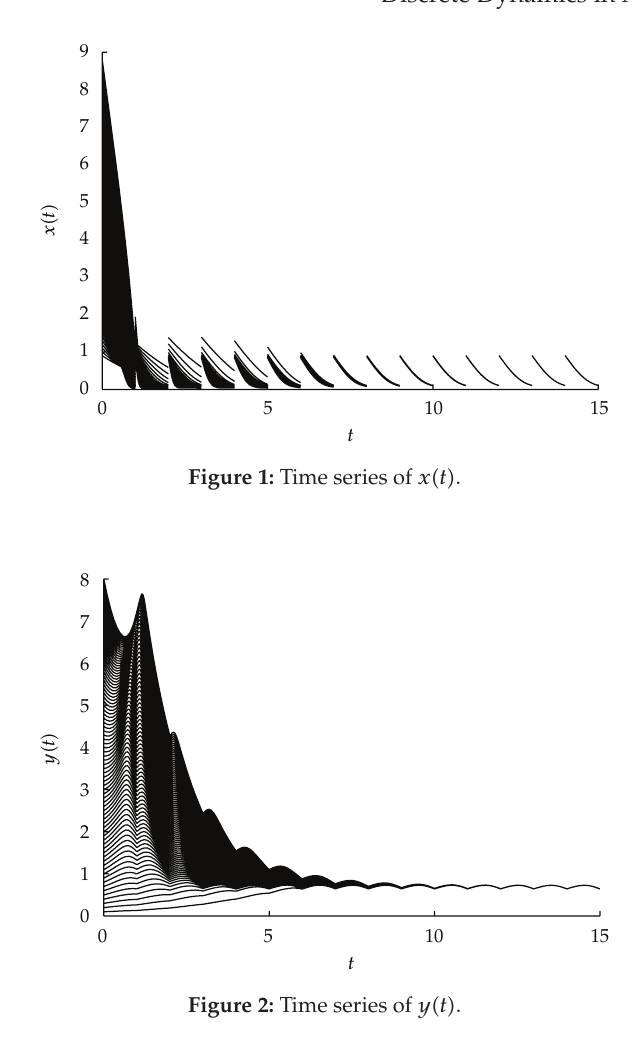
Figure 2: Time series of y (cid:7) t (cid:8)